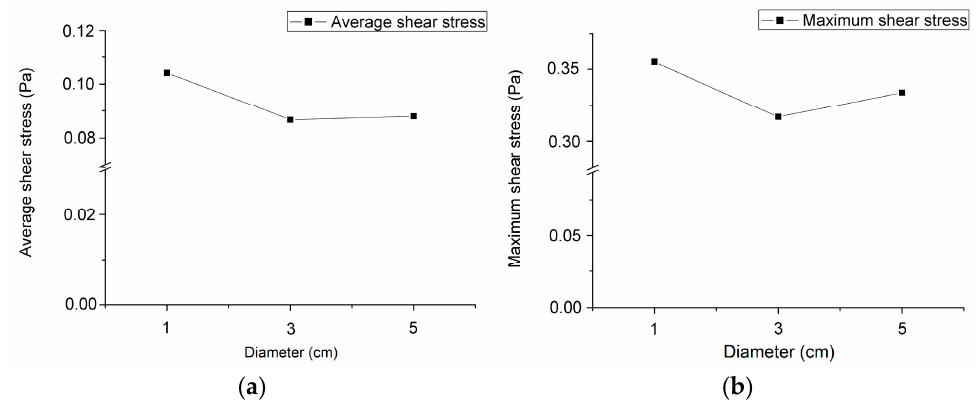
Figure 5. The variation of ( a ) the average shear stress, and ( b ) the maximum shear stress along the specific diameter as defined in Figure 3 on the bottom surface of the container with three rotating diameters. (Rotating speed = 120 rpm and container’s diameter = 3 cm)